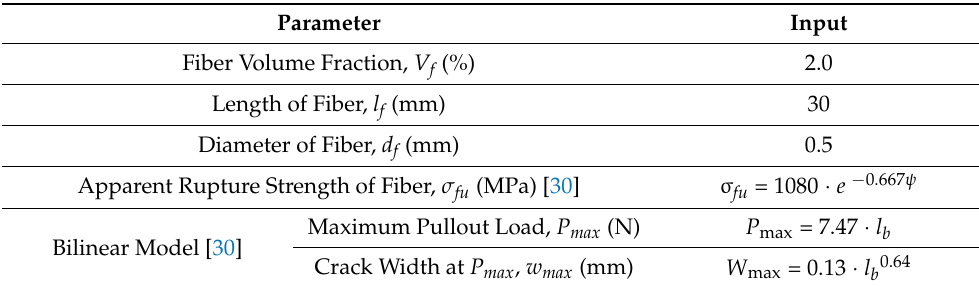
Table 1. Parameters for bridging law calculation.